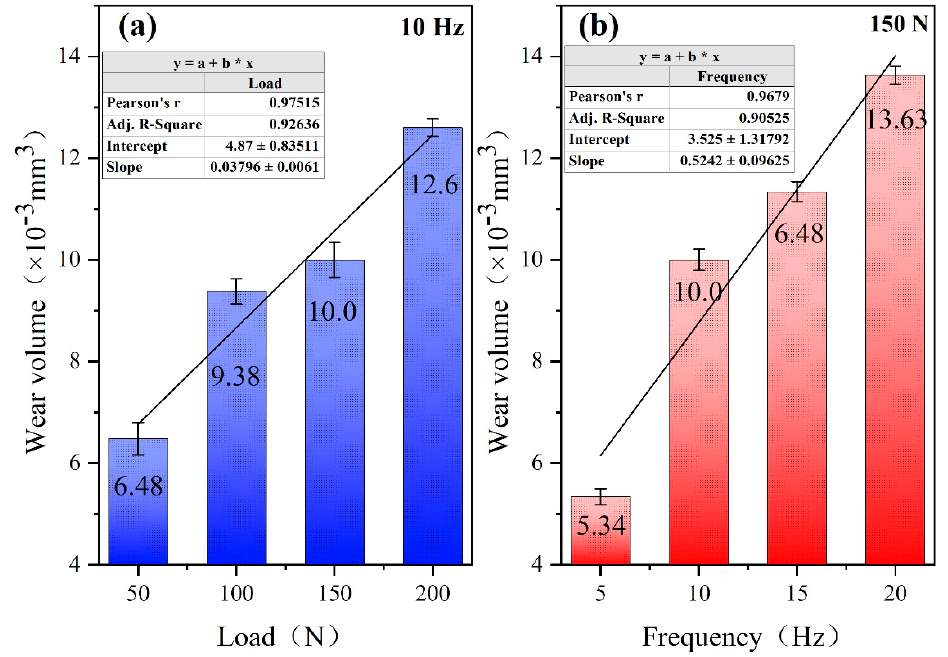
Figure 10. The WVL of each specimen with different: ( a ) loads and ( b ) reciprocating frequencies.